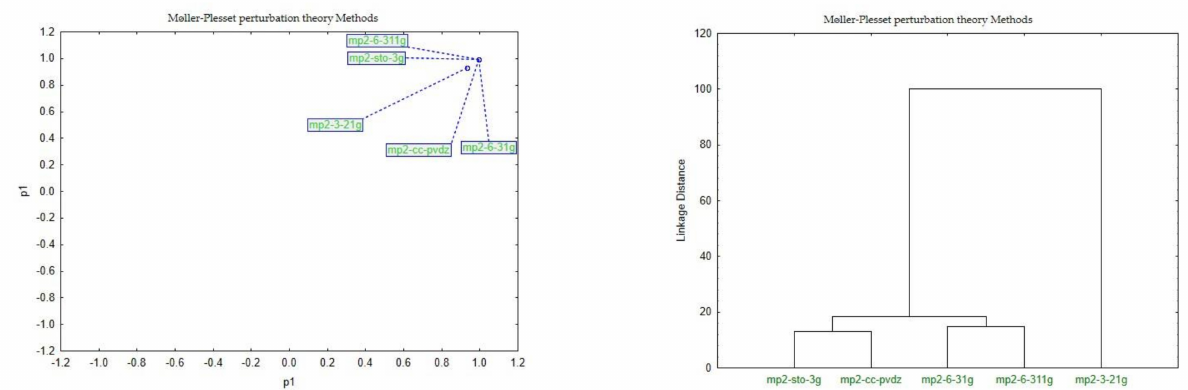
Figure 8. Score plot showing the distribution of the methods in the principal components p1 and p2 and cluster